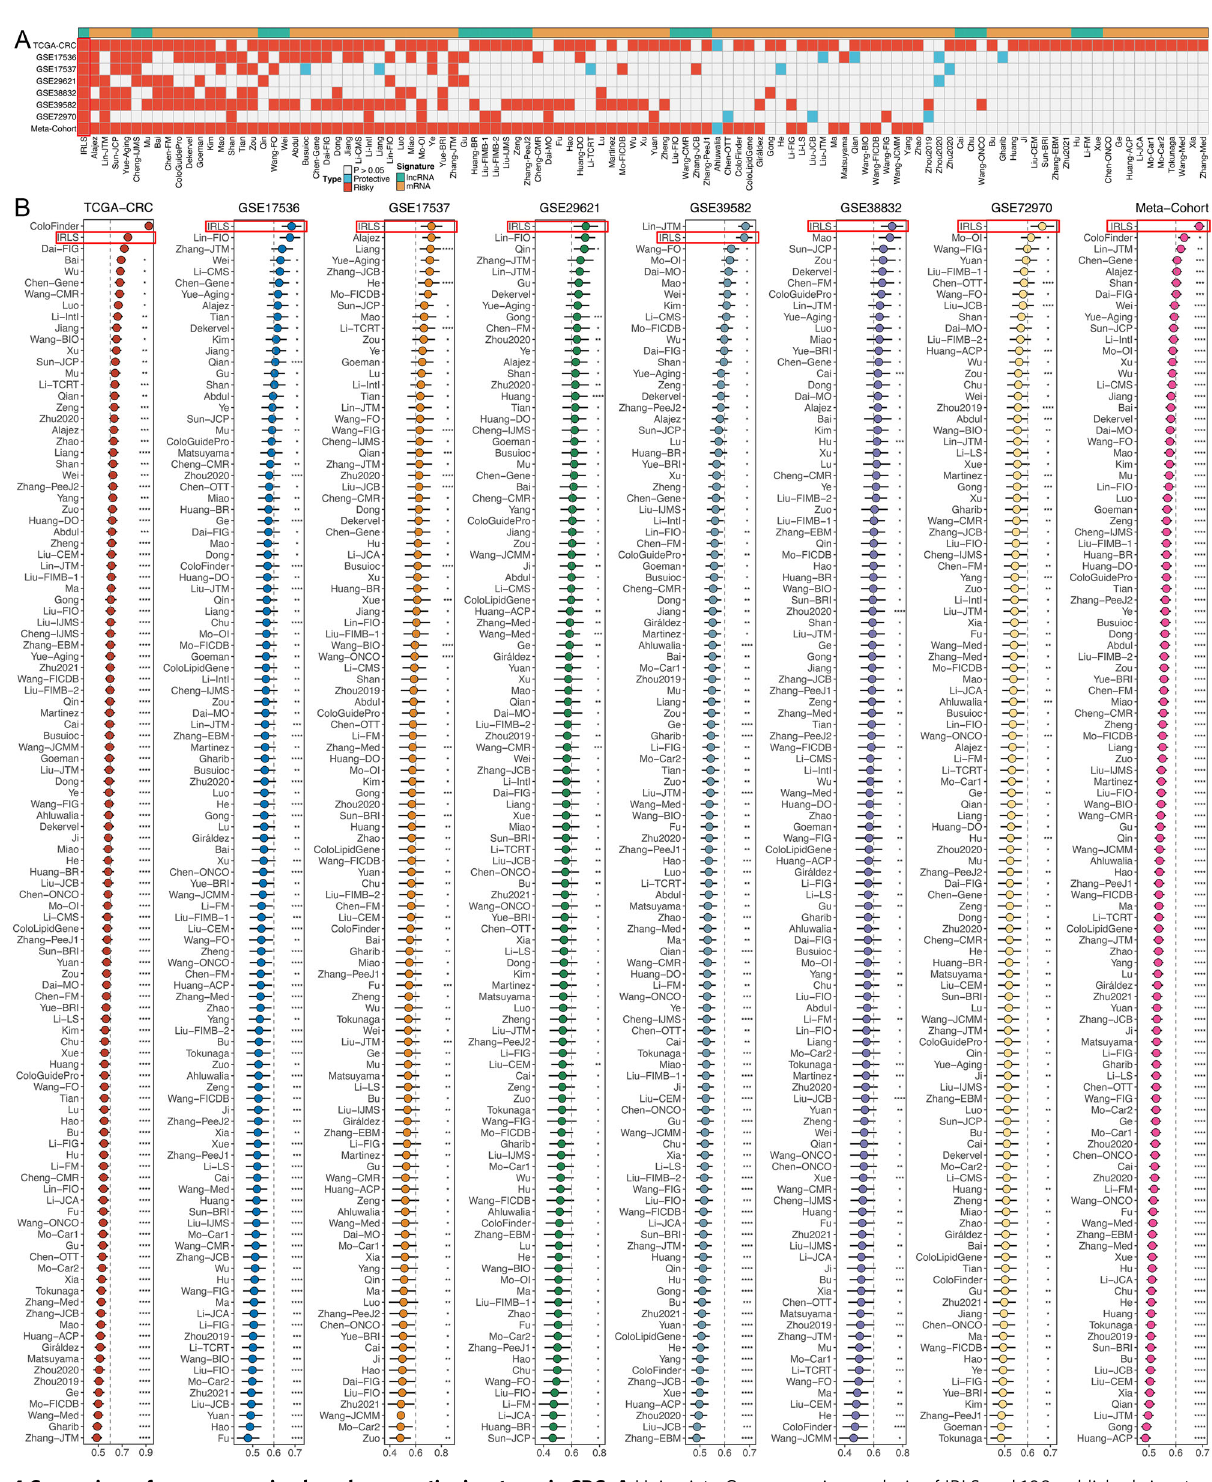
NATURE COMMUNICATIONS| (2022) 13:816